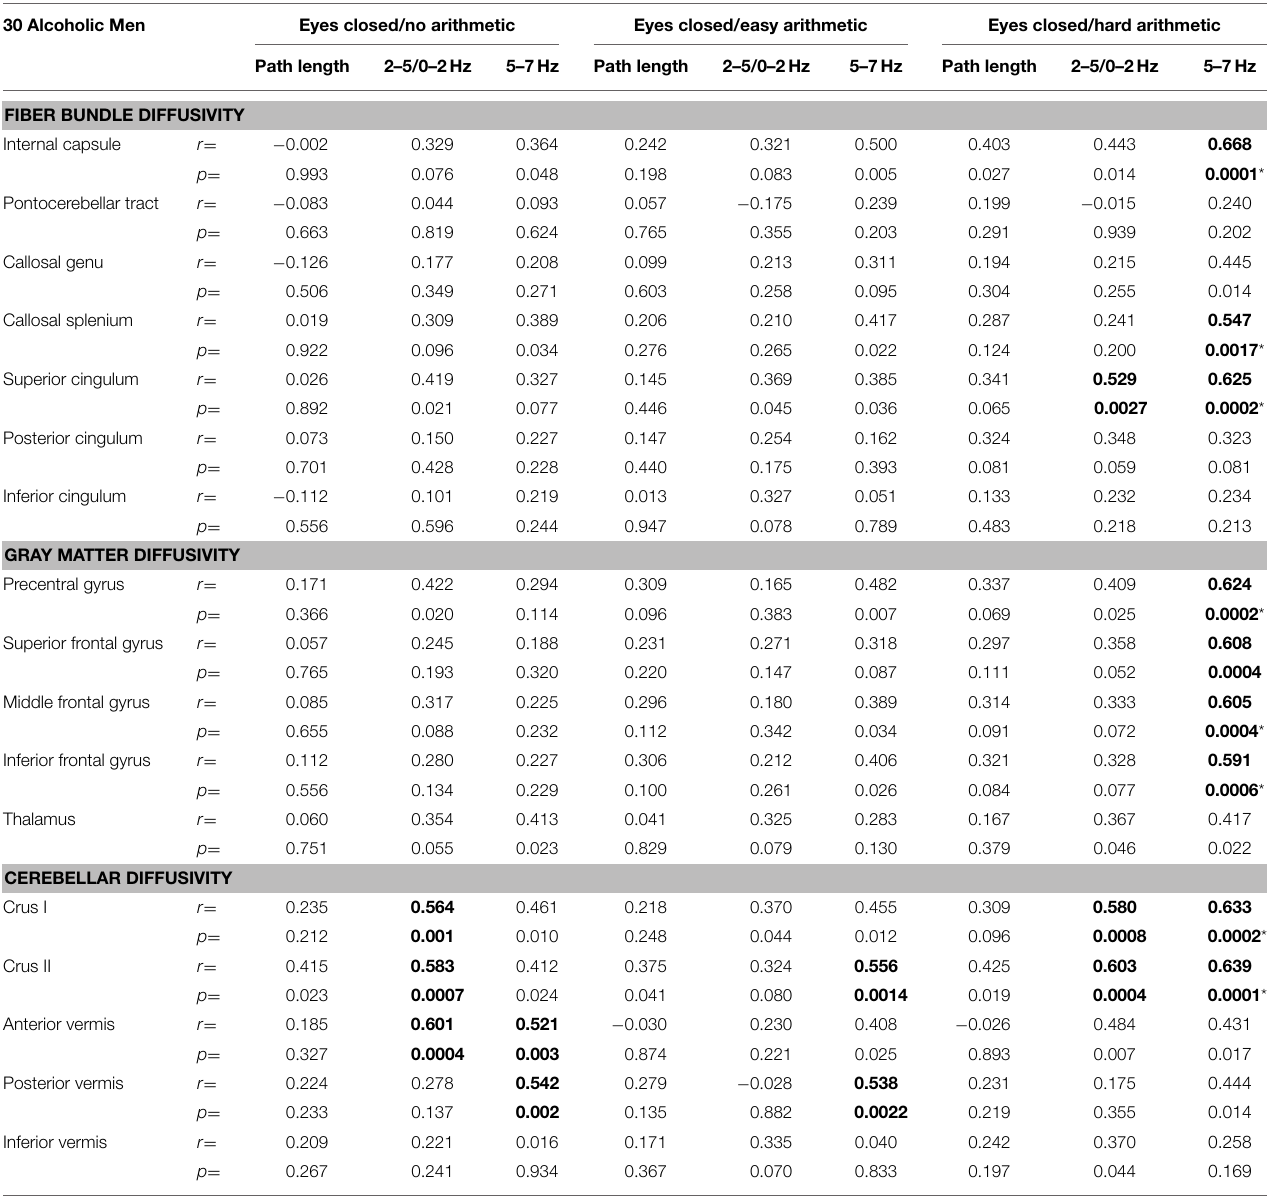
TABLE 2 | Pearson correlations between balance metric (eyes closed) and DTI diffusivity.